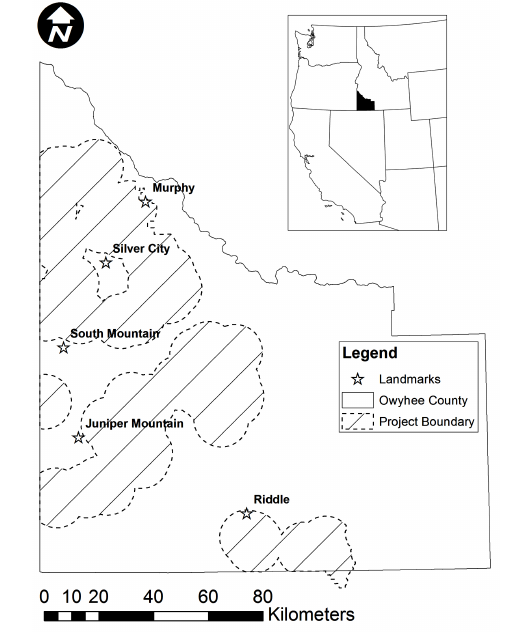
Fig. 2 . Owyhee County, Idaho and the Bruneau-Owyhee Sage- Grouse Habitat (BOSH) project area